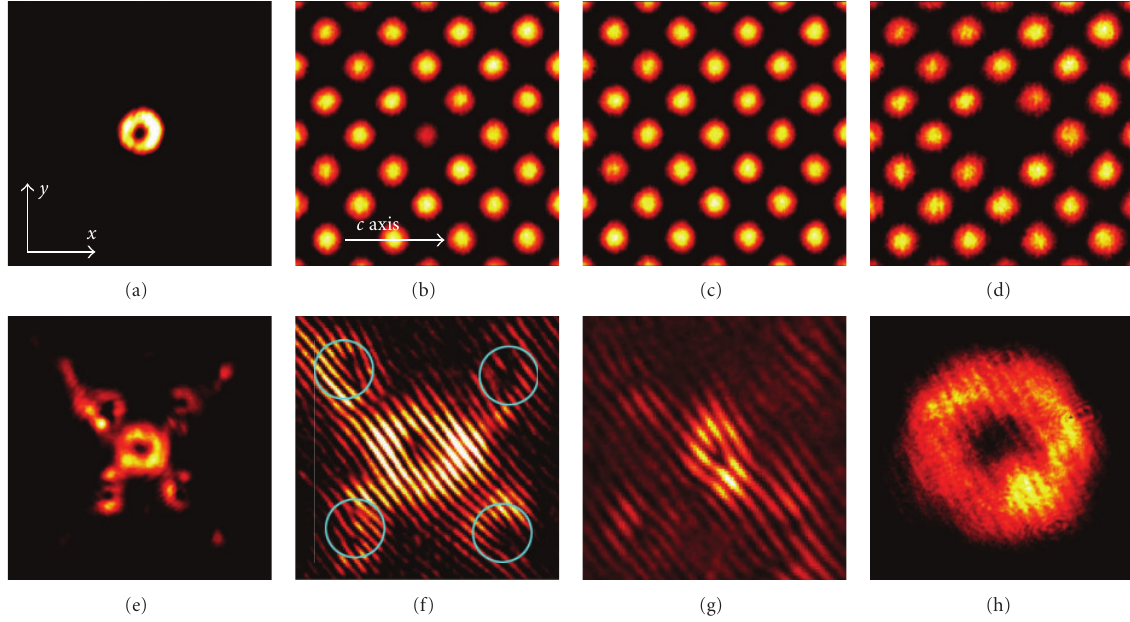
Figure 7: Experimental results of bandgap guidance of a vortex beam in a tunable negative defect. (a) Vortex at input. (b)–(d) Induced lattices with nonzero-intensity defect, no defect, and zero-intensity defect, respectively. (e), (f) Vortex output from the defect in (b) and its zoom-in interferogram. The circles in (f) mark the location of the vortex pairs. (g) Interferogram when the vortex is excited at nondefect site. (h) Vortex di ff raction output when lattice is